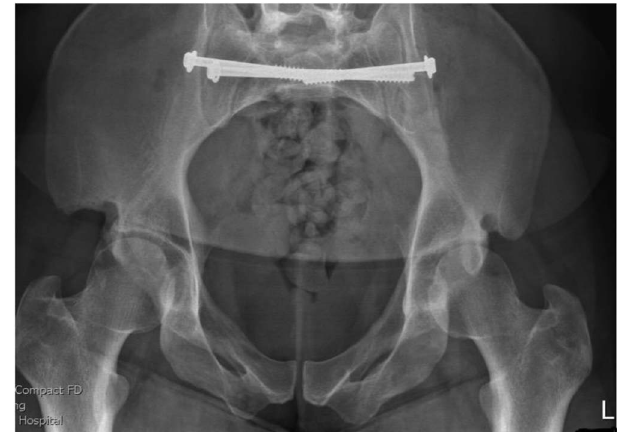
Figure 9. Day 1 after fi xation. Bilateral sacroiliac joint screws with INFIX. Outlet view. Figure 11. After union and removal of INFIX. Mild right-sided heterotopic ossi fi cation noted. Inlet image.